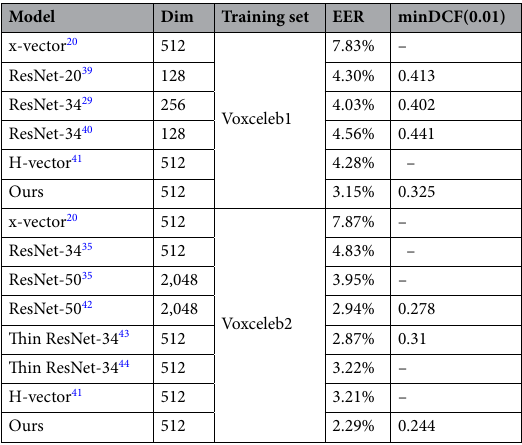
Table 3. Comparison of the proposed method with the existing research on Voxceleb1 test set. Dim represents the dimension of the embedding